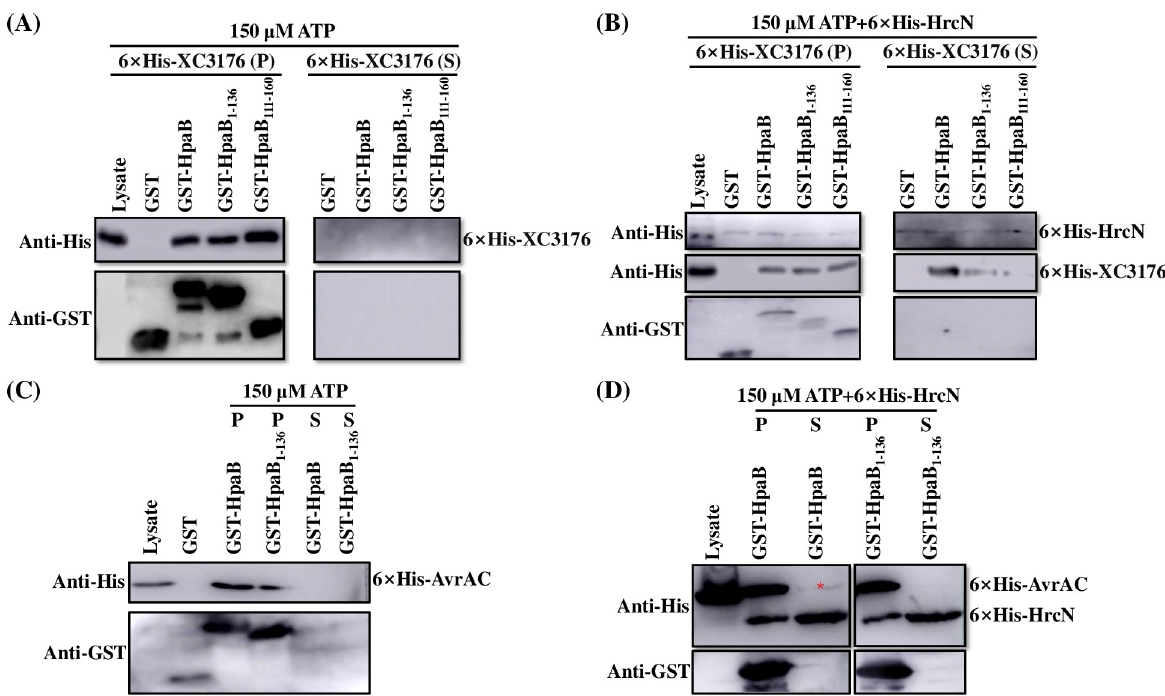
Fig 8. The C-terminal domain of HpaB is involved in ATPase-dependent dissociation of chaperone-effector complex in Xcc . ( A-B ) The T3E XC3176 binding to impaired chaperone is not released by purified 6 × His-HrcN. Chaperone-effector complexes (GST-HpaB/6 × His-XC3176, GST-HpaB 1-136 /6 × His-XC3176, and GST-HpaB 111-160 /6 × His-XC3176) and GST were absorbed on MagneGST TM particles and incubated without ( A ) or with ( B ) 6 × His-HrcN 1 h at room temperature in presence of 150 μ M ATP, respectively. The released proteins in supernatant (S) and preyed proteins (P) on MagneGST TM particles were separated by magnet. Samples were analyzed by immunoblotting with hexahistidine-specific antibody and GST-specific antibody. ( C-D ) The C-terminal domain of HpaB is crucial for liberating T3E AvrAC. ( C ) Chaperone-effector complexes of (GST-HpaB/6 × His-AvrAC and GST-HpaB 1-136 /6 × His-6 × His-AvrAC and GST alone were absorbed on MagneGST TM particles and incubated 1 h at room temperature in presence of 150 μ M ATP, respectively. ( D ) One μ g purified 6 × His-HrcN was incubated with GST-HpaB/ 6 × His-AvrAC and GST-HpaB 1-136 /6 × His-AvrAC complex immobilized on MagneGST TM particles, respectively, in presence of ATP. The released 6 × His-AvrAC at a weak level was remarked with asterisk.